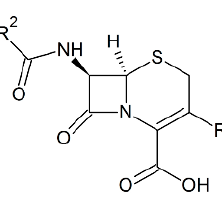
Figure 2. Chemical structure of the cephalosporin nucleus.